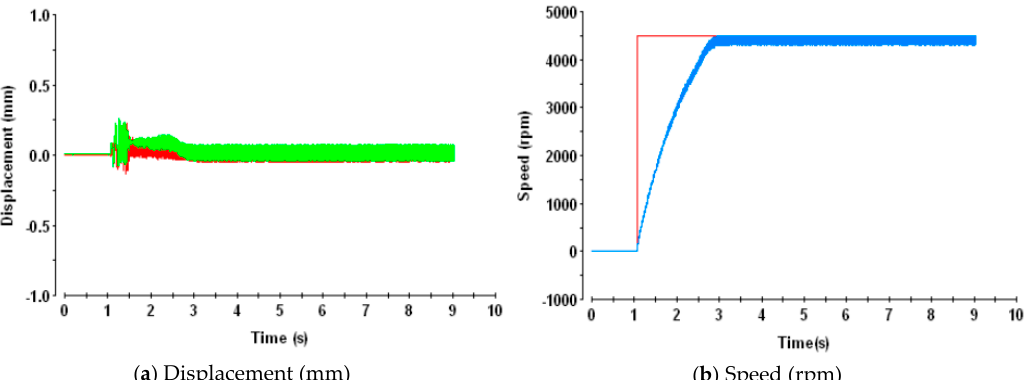
Figure 18. Response of displacement and speed at start without load.